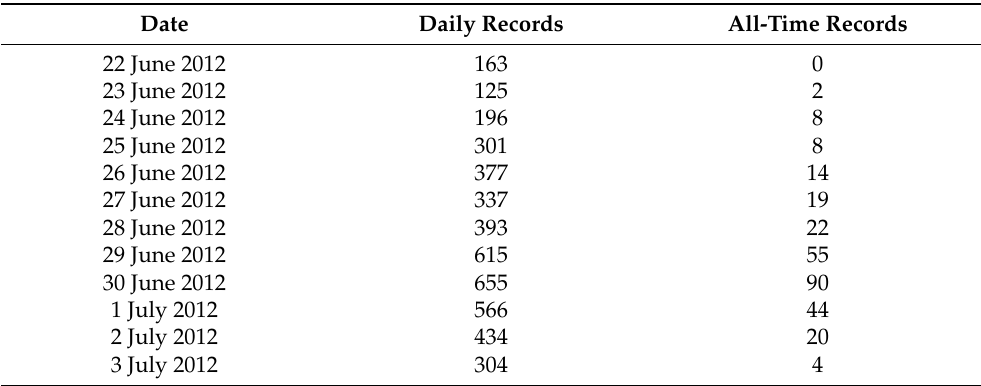
Table 2. Summary of daily and all-time high temperature records from 22 June through 3 July 2012 [30].